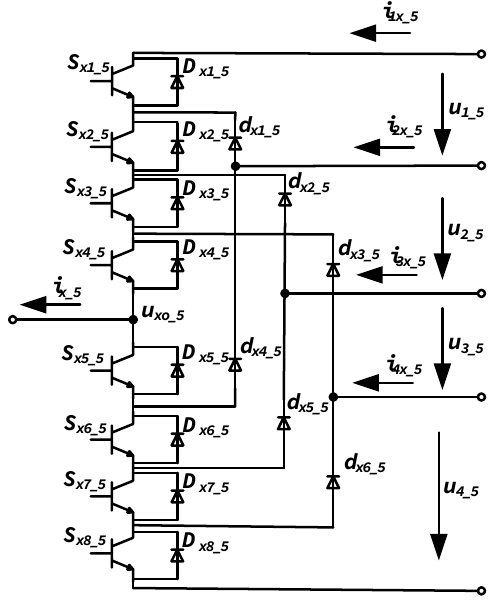
Figure 6. Topology of a single five-level